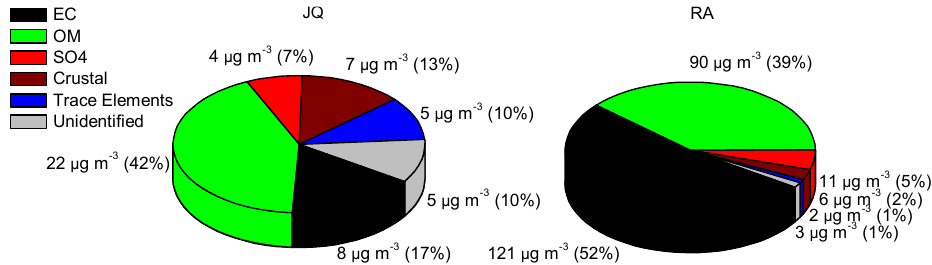
Fig. 6. Chemical mass balance in the JQ (left) and in the RA (right) tunnels. The crustal mass (brown fractions) was calculated by combining the mass of the elements uniquely apportioned to crustal sources and half of the mass (as approximation) of elements apportioned to both vehicular and crustal sources (Sect. 3.1.1). Sulphate mass (red fractions) was estimated from S using a factor of 3 (corresponding to the atomic mass of S relative to SO 42 − mass). The other elements, excluding S and crustal, are grouped as trace elements (blue fractions). The organic mass (OM) (green fractions) is estimated from OC measurements using a ratio of 1.6 for the JQ tunnel and 1.5 for the RA tunnel. The difference between PM 2 . 5 mass determined gravimetrically and the sum of identified compounds are labelled as unidentified compounds (grey